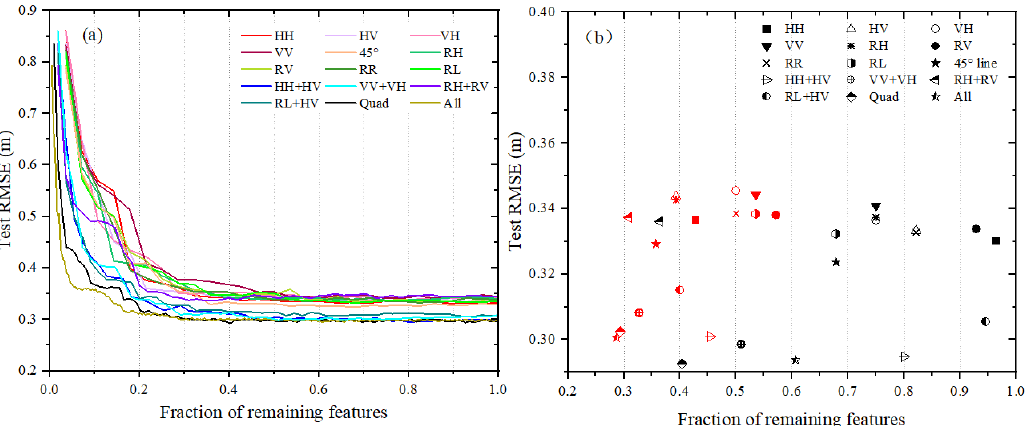
Figure 7. The performance of XGBoost models for SWH retrieval using different input features under 15 polarizations compared with ERA5 SWH. ( a ) The relationship of the fraction of remaining features and RMSEs of the SWH derived from XGBoost under 15 polarization modes, with different colors representing different polarizations. ( b ) Performance of XGBoost models based on the optimal feature sets (red) and the best feature sets (black) under 15 polarization modes (different symbols). Table 2. The number of inputs and the performance of 15 polarization models for SWH retrieval using different input combinations, including all features extracted from SAR imagettes, the best feature sets, and the optimal feature sets.